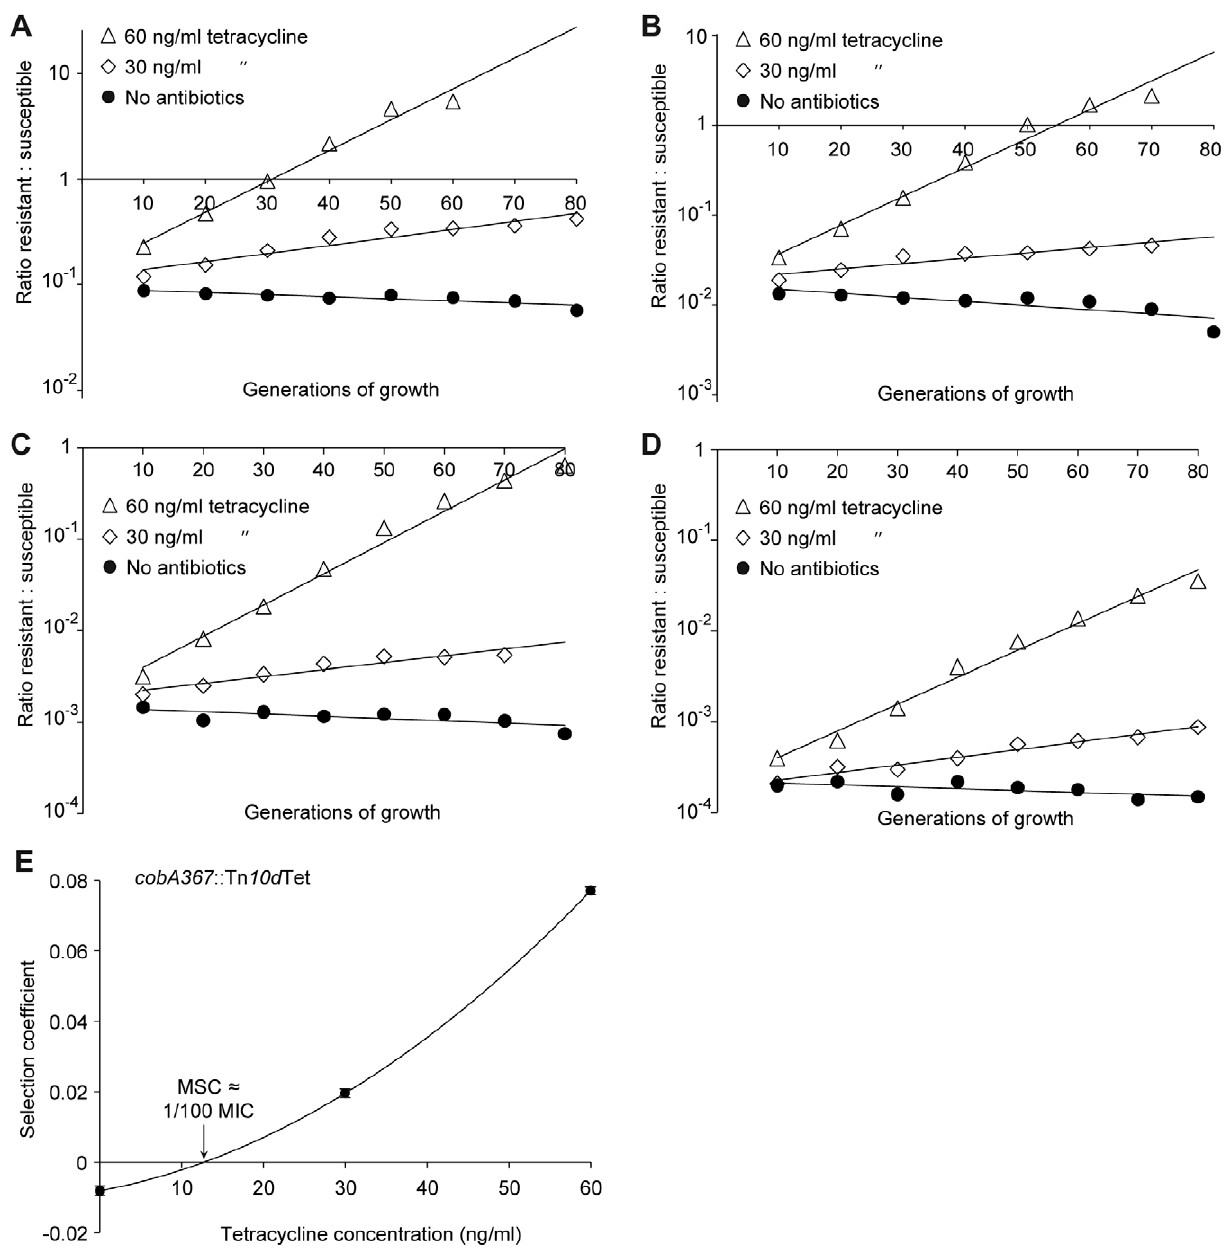
Figure 4. Competition experiments with low initial frequencies of resistant mutants. Competition experiments at different concentrations of antibiotics and different starting fractions of resistant mutants. (A) Initial ratio of susceptible to resistant mutants 10:1. (B) Initial ratio of susceptible to resistant mutants 10 2 :1. (C) Initial ratio of susceptible to resistant mutants 10 3 :1. (D) Initial ratio of susceptible to resistant mutants 10 4 :1. (E) Calculated selection coefficients as a function of antibiotic concentrations. Fig. A to D are each based on one single competition experiment while E is calculated from the selection coefficients of 24 independent competitions with four different starting fractions of resistant mutants (Table S3 in Text S1). Standard errors of the mean are indicated.